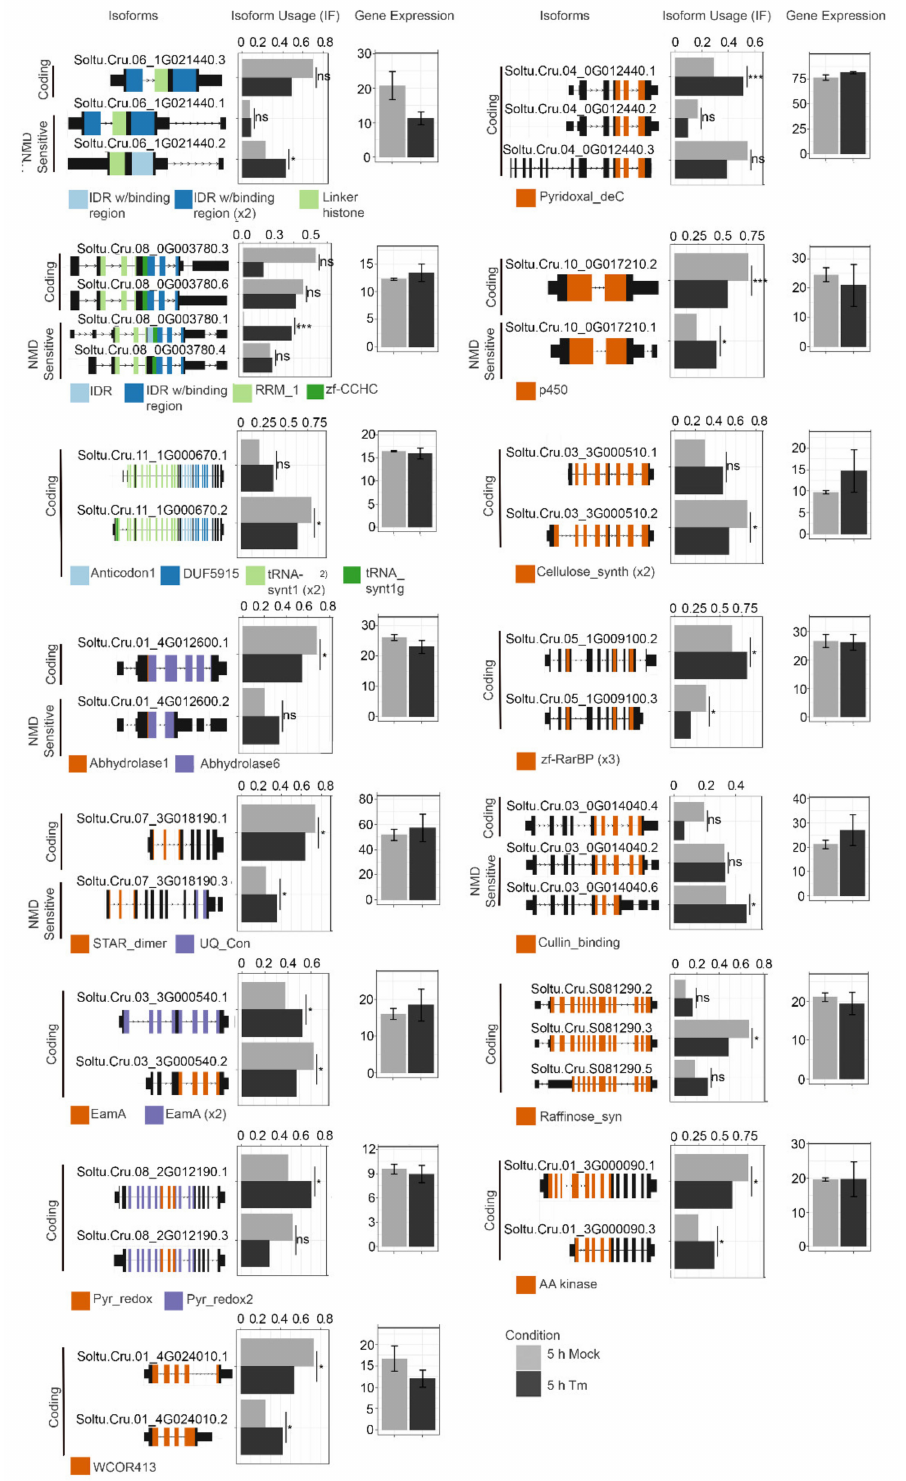
Figure 5. Isoform enrichment analysis at 5 h. Selected isoforms and their differential expression are shown. Coding potentials, NMD sensitivities, and functional PFAM domains are indicated. *— p < 0.05, ***— p < 0.001, ns—not